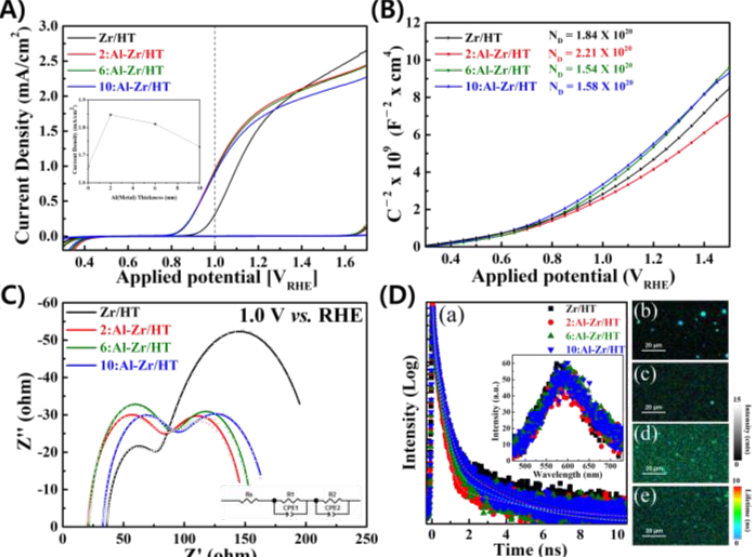
Figure 3. ( A ) Photocurrent density-potential ( J – V ) curves under light (solid lines) and dark (dashed lines) conditions; ( B ) Mott–Schottky plots (under dark); ( C ) EIS Nyquist plots of photoanodes using 1 M NaOH electrolyte under 1-sun standard illumination conditions at 1.0 V vs. RHE for the Zr/HT, 2:Al-Zr/HT, 6:Al-Zr/HT, and 10:Al-Zr/HT photoanodes; and ( D ) ( a ) Time-resolved PL decays of the Zr/HT (square; black), 2:Al-Zr/HT (circle; red), 6:Al-Zr/HT (up triangle; blue), and 10:Al-Zr/HT (down triangle; purple) under a 470 nm laser excitation. Inset is the steady-state PL spectrum of the corresponding photoanodes. PL lifetime images of the ( b ) Zr/HT, ( c ) 2:Al-Zr/HT, ( d ) 6:Al-Zr/HT, and ( e ) 10:Al-Zr/HT.